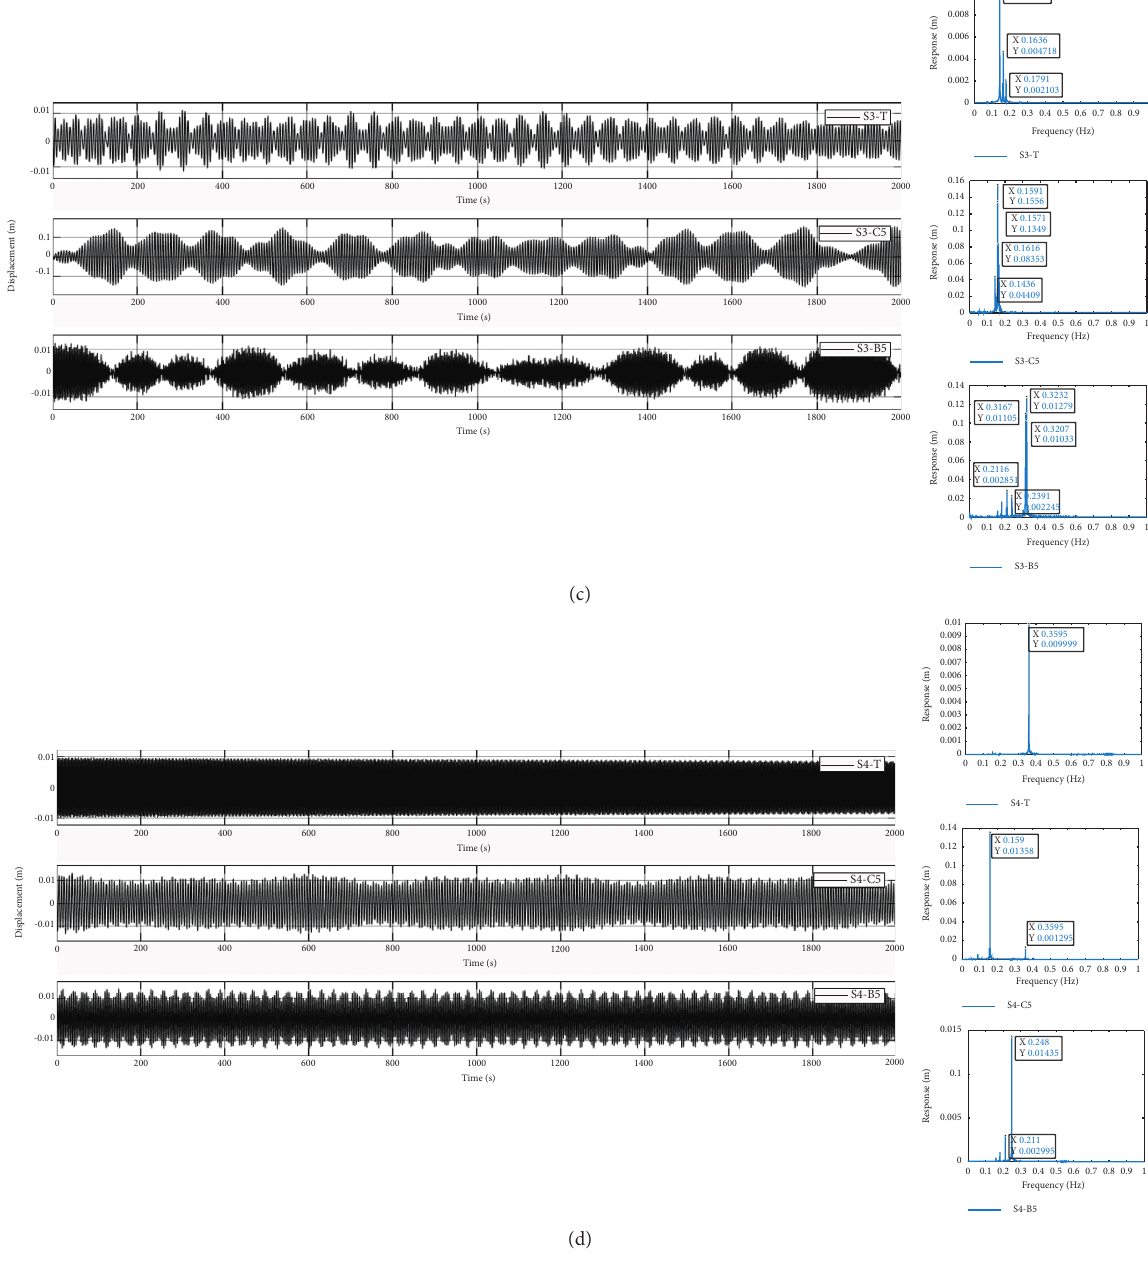
Figure 12: The spectrograms of each component under different working conditions. (a) Under S cable, and beam in the C 5 subsystem. (b) Under S 2 condition, the spectrograms of the tower, cable, and beam in the C 5 subsystem. (c) Under S 3 condition, the spectrograms of the tower, cable, and beam in the C 5 subsystem. (d) Under S 4 condition, the spectrograms of the tower, cable, and beam in the C 5